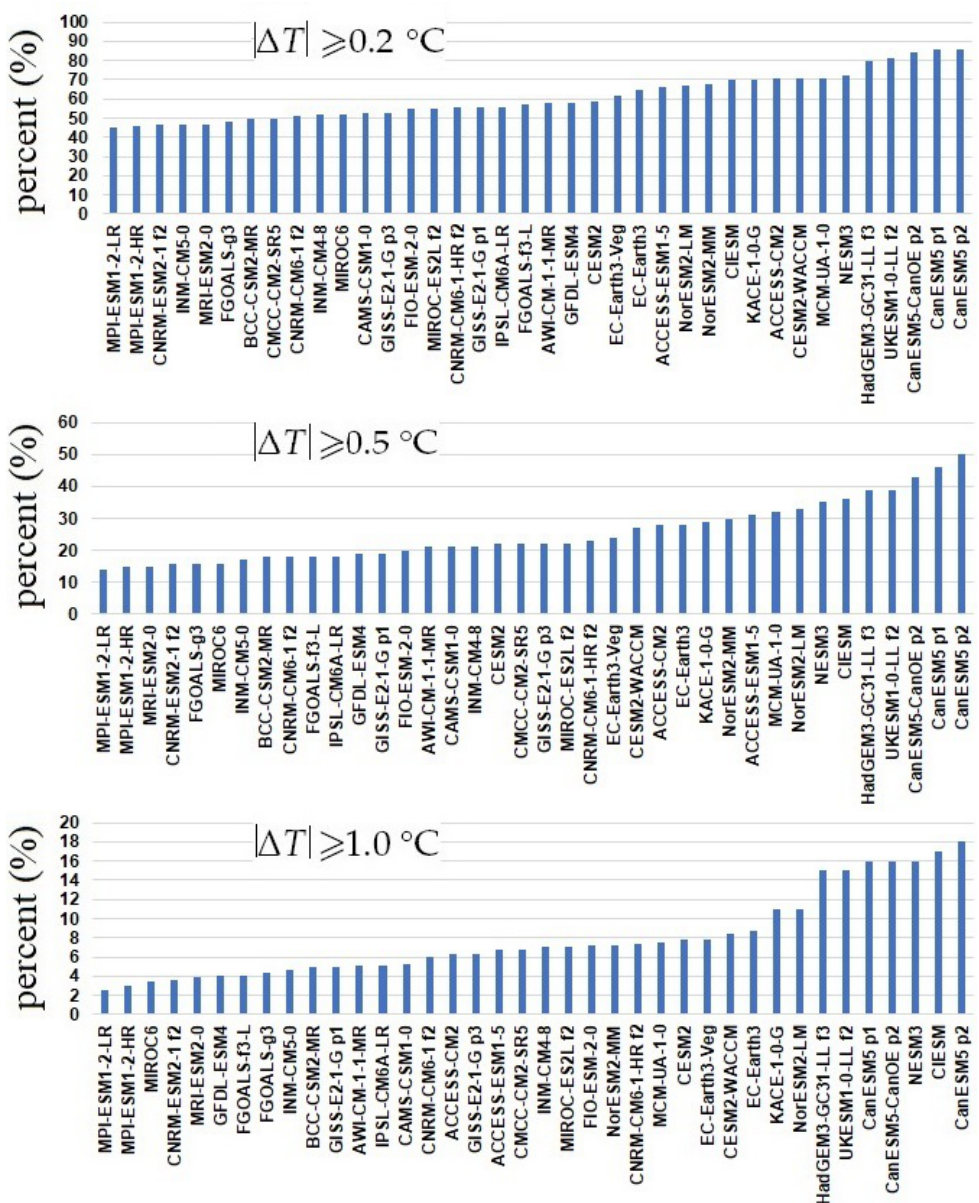
Figure 8. Model ranking relative to the percentage of the world area where the disagreement between each of the CMIP6 GCMs and the ERA5-T2m record is ∆ T (cid:62) 0.2 °C, ∆ T (cid:62) 0.5 °C and ∆ T (cid:62) 1.0